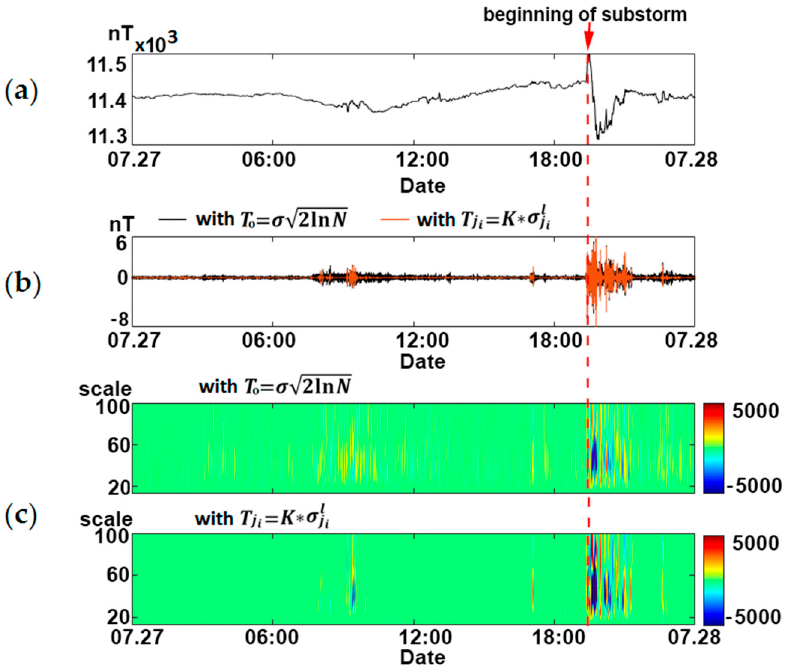
Figure 4. ( a ) Signal; ( b , c ) method application (without nodes (𝑗 (cid:3036) ,0) ).